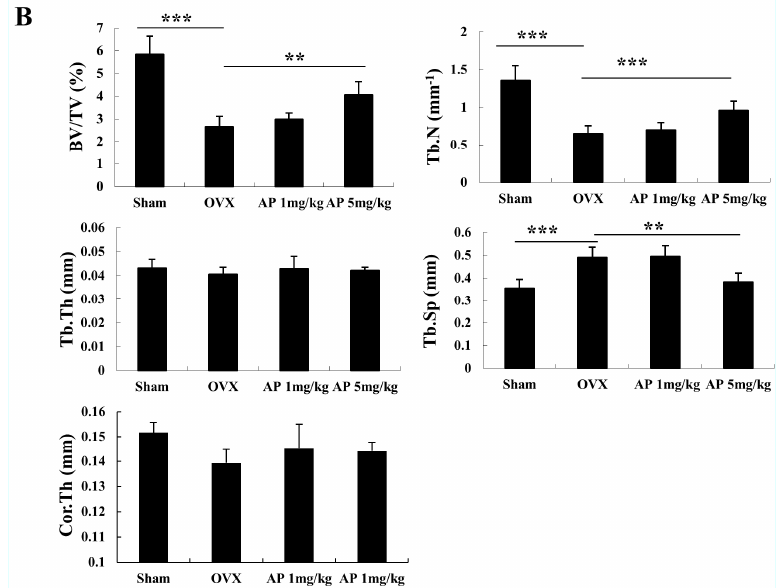
Figure 1. Andrographolide inhibits OVX-induced bone loss. A week after ovariectomy, mice were injected with vehicle (1% DMSO) or AP (1 or 5 mg/kg) every two days for a six-week period. ( A ) representative 3D images showing tibias of mice scanned with micro-CT; and ( B ) analyses of microstructural indices including bone volume per tissue volume (BV/TV), trabecular number (Tb.N), trabecular thickness (Tb.Th), trabecular separation (Tb.Sp), and cortex thickness (Cor.Th) calculated by micro-CT. n = 6, ** p < 0.005; *** p < 0.001.